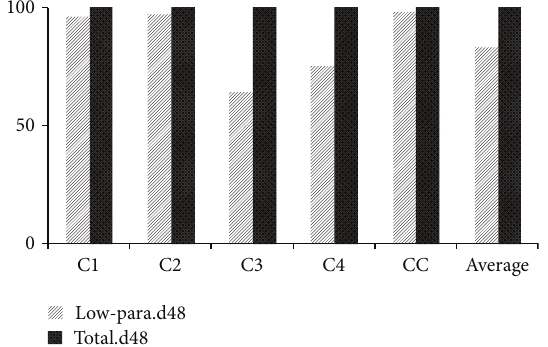
Figure 10: Neonatal mortality within 48 hours. “d48” stood for neonates that die within 48 hours of presentation, “low-para.d48” counted the size of very low parameter ( ≤ 1500g or < 33 wks) cases within the d48 baby population.